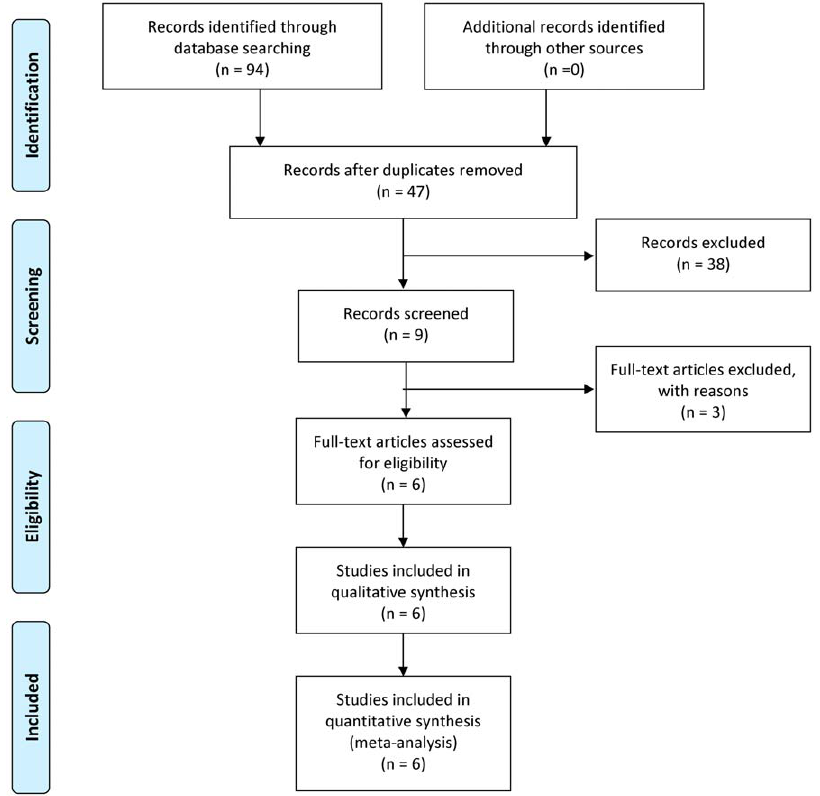
Figure 1. Flow diagram of the selection of eligible studies.